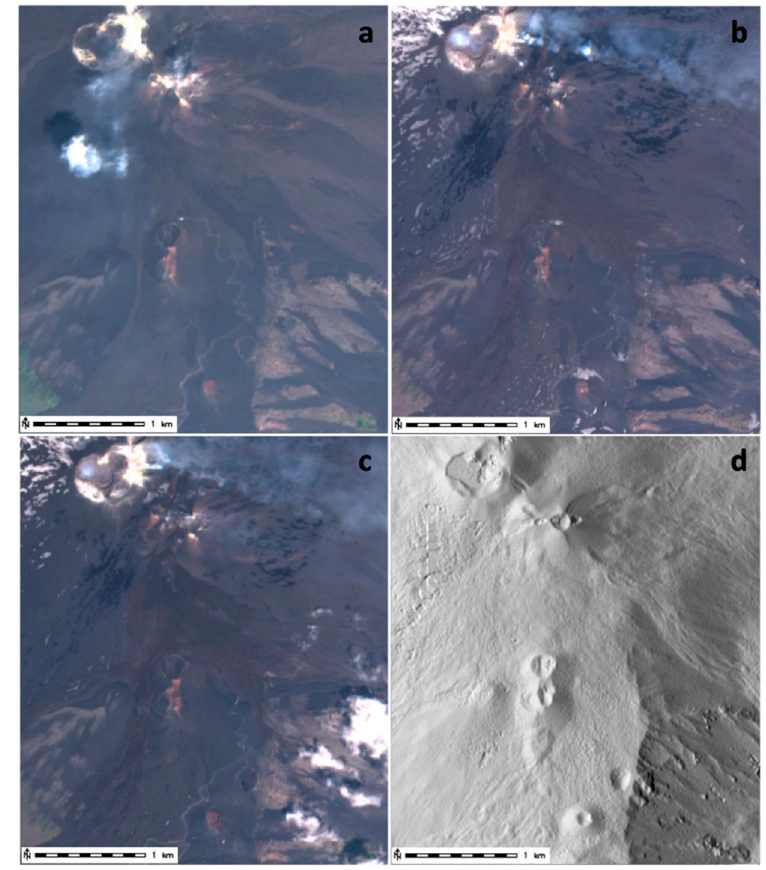
Figure 4. RGB composition from Sentinel-2 MSI data (Red—Band 4, Green—Band 3, Blue—Band 2) of the pre-eruptive area 9 July 2016 ( a ), post-eruptive area 30 April 2017 ( b ) and 8 May 2017 ( c ) and DEM 2016 ( d ) restricted to the lava flow region.